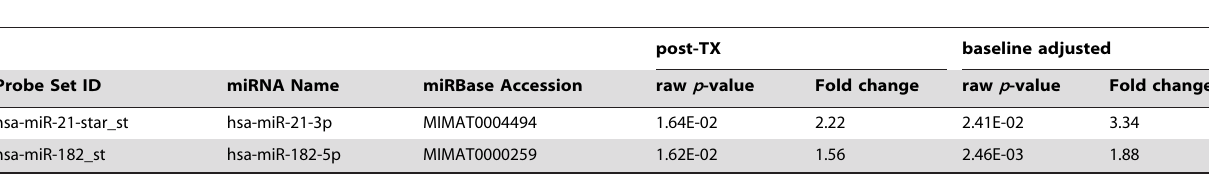
Table 3. AKI miRNA signature as verified in the evaluation